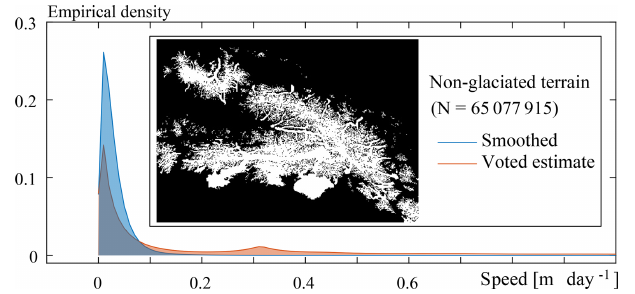
Figure 8. Distribution of the speed over stable terrain, for displace- ments extracted from the voting process, or after spatial temporal smoothing. The mask used is within the